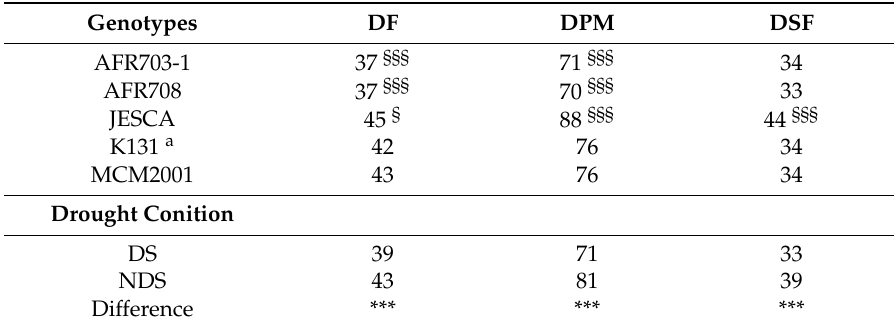
Table 2. Crop phenology of common bean as affected by genotypes and drought conditions in the field,